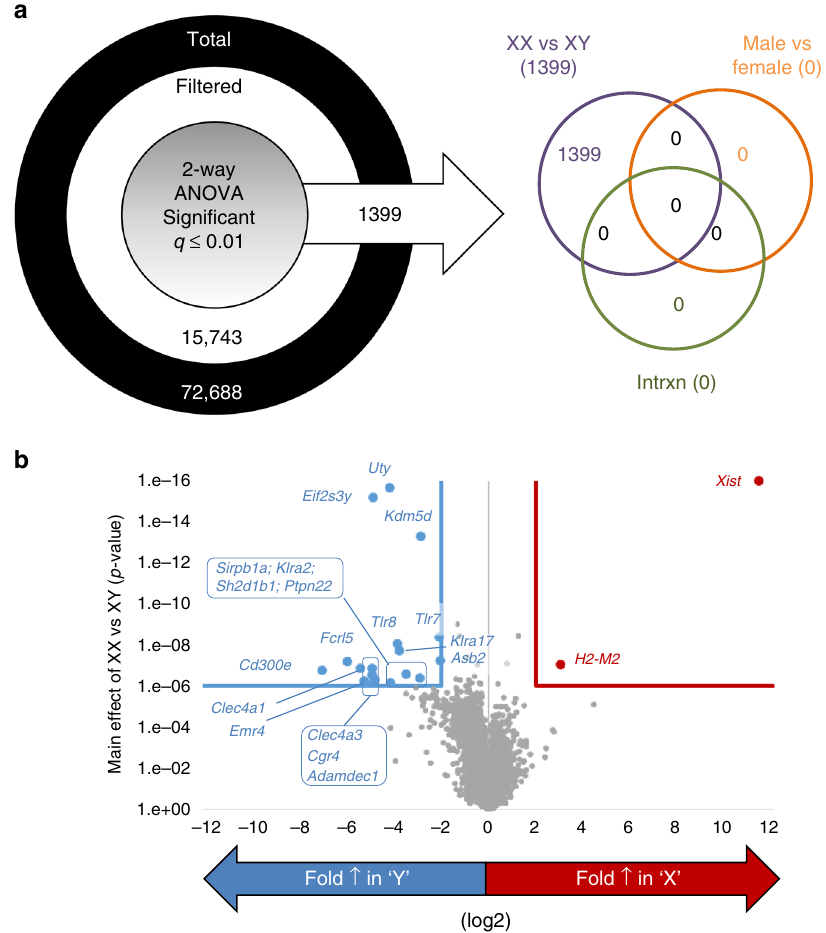
Fig. 4 Sex chromosome complement in fl uences hepatic gene expression of Ldlr − / − gonadectomized (GDX) mice. a Total probe sets on the array were fi ltered to retain annotated transcript clusters with reliable signal intensity. The fi ltered data set was analyzed by two-way ANOVA. The number of genes whose expression was signi fi cantly changed (multiple testing corrected q value ≤ 0.01) by the main effects of gene status (XX vs XY), biological sex (male vs. female), as well as by interaction, are listed. Note that only genes signi fi cant by the chromosome effect survived multiple testing correction. b Fold change in gene expression (log 2 scale, x -axis) and statistical signi fi cance ( p value, y -axis) for the main effect of chromosome are plotted. Genes labelled in blue exhibited signi fi cant increases in livers from XY compared to XX mice; genes labelled in red exhibited signi fi cant increases in livers from XX compared to XY mice. (FXX, n = 5; FXY, n = 5; MXX, n = 4; MXY, n = 5). Source data are available as a Source Data fi le